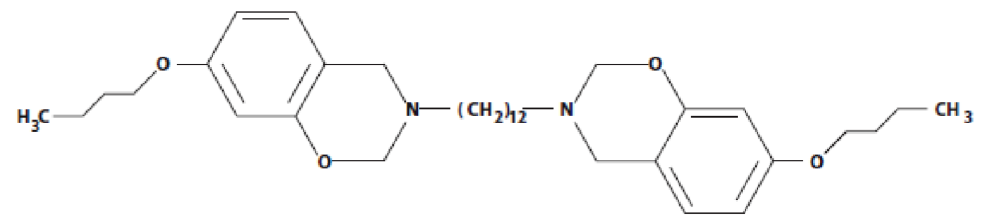
Figure 2. Molecular structure of the optimized 3BOP-daC12 benzoxazine monomer. From [53], originally published under a CC-BY license.